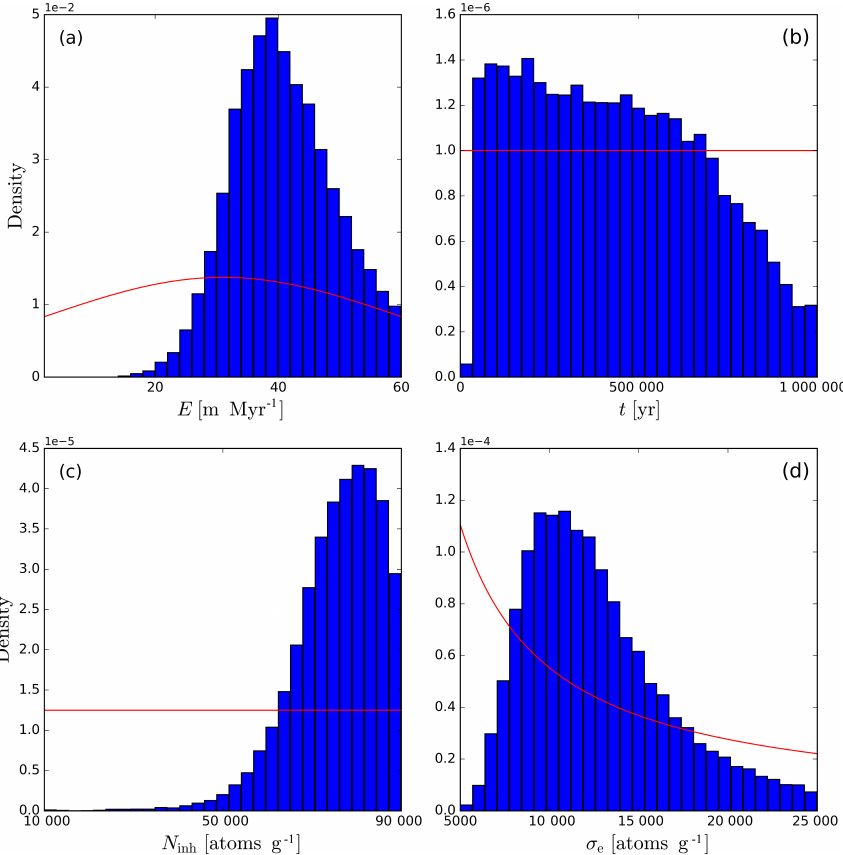
Figure 7. Marginal posterior distributions of the four parameters sampled using our approach: (a) erosion rate, (b) exposure age, (c) inherited 10 Be concentration and (d) standard deviation of the residual errors. The blue bars denote the posterior PDFs and the red lines signify the associated prior